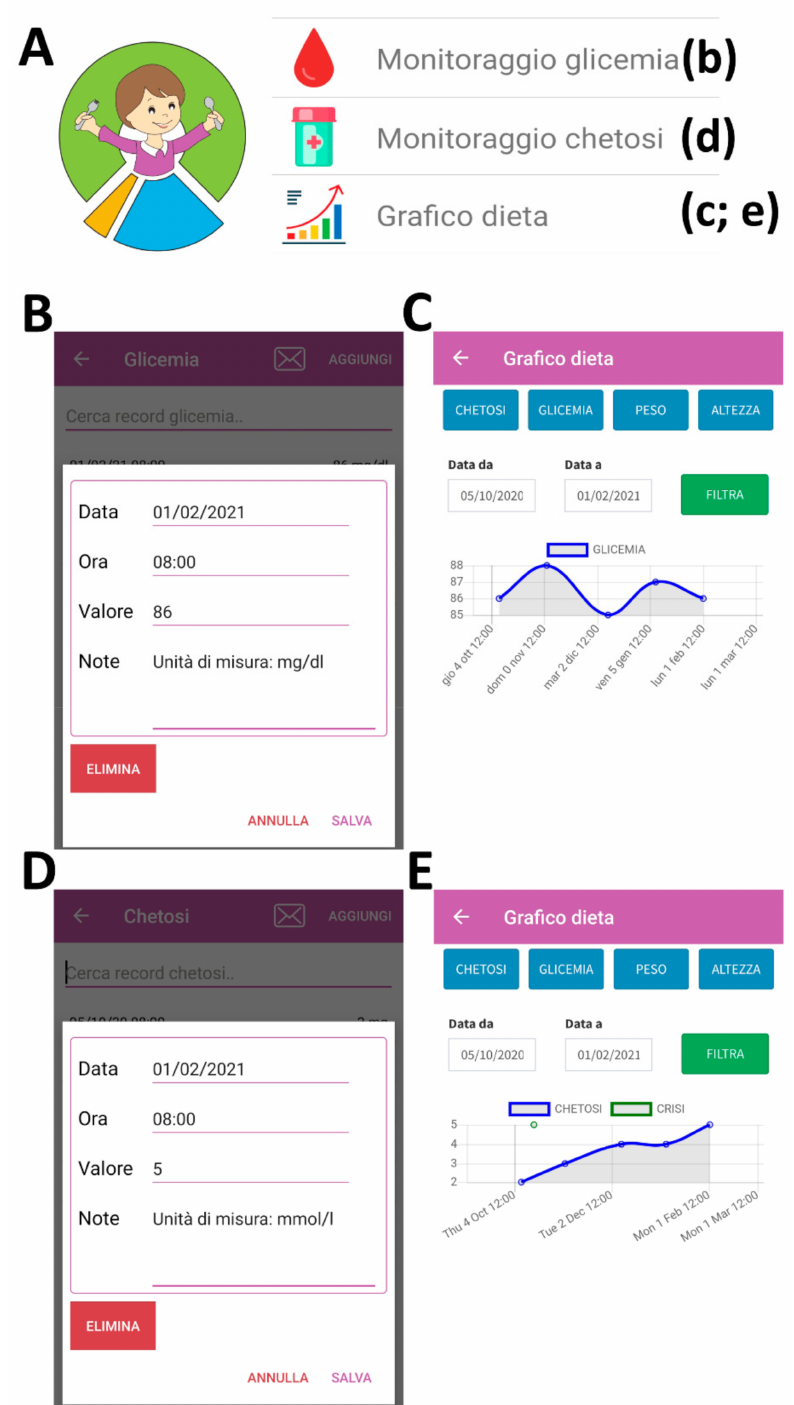
Figure 2. Using the app to record blood glucose and ketosis values. The logo and the second part of the drop-down menu are reported in ( A ). An example of recording of the blood glucose value (mg/dl) is reported in ( B , C ). An example of recording of the ketosis value (mmol/L) is reported in ( D , E